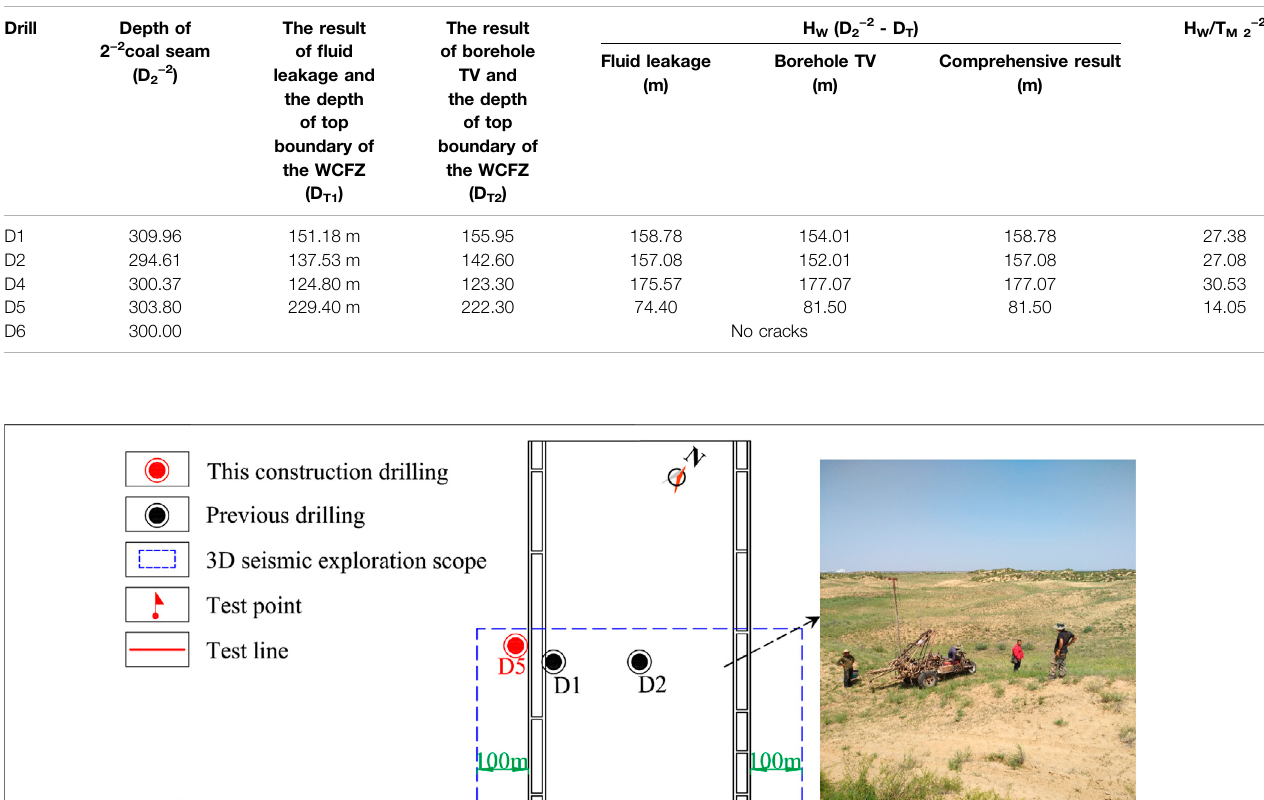
TABLE 1 | Height of WCFZ development.